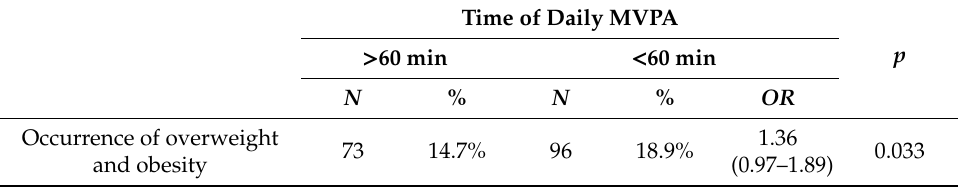
Table 5. Odds ratio of overweight and obesity depending on the time of daily MVPA.